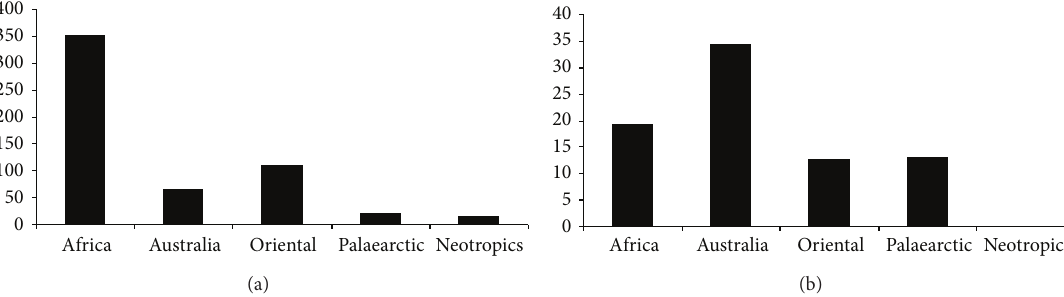
Figure 4: Number of valid species of Paussini per biogeographical region (a) and percentage of synonymous taxa of Paussini per biogeographical region (b).